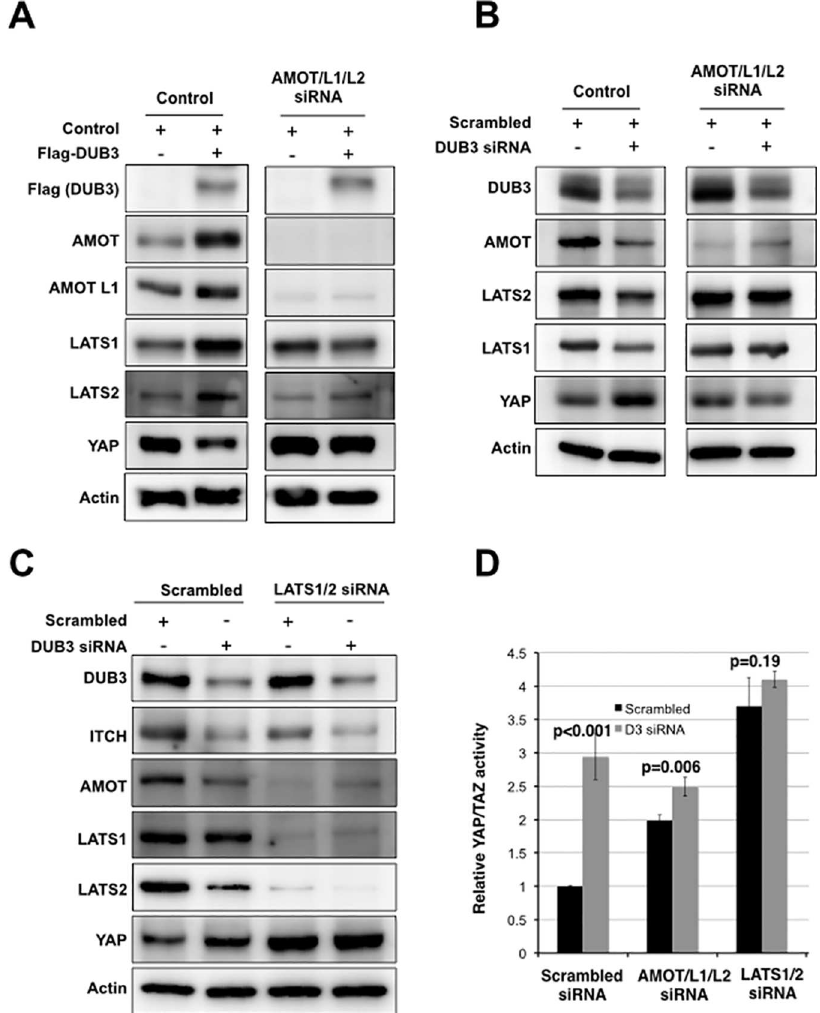
Fig 3. LATS and AMOT proteins are required for DUB3-mediated regulation of Hippo signaling. (A) Immunoblots showingthe effect of DUB3 expressionon LATS kinases, AMOT and YAP. HEK293T cells were transfected with a vector expressingFlag-DUB3or a control vector together with a mixture of siRNAs targeting AMOT, AMOTL1 and AMOTL2 or a scrambledsiRNA control. Blots were probedwith antibodies againstFlag, AMOT, AMOTL1, LATS1, LATS2 and YAP. Anti-Actin was used to control for loading.Samples were run on the same SDS-acrylamide gels with intervening lanes removed. (B) Immunoblots showingthe effect of DUB3 depletion on LATS kinases, AMOT and YAP. HEK293T cells were transfected with a vector expressingFlag-DUB3 or a control vector togetherwith a mixture of siRNAs targeting AMOT, AMOTL1 and AMOTL2 or a scrambledsiRNA control. Blots were probedwith antibodiesagainst DUB3, AMOT, LATS1, LATS2 and YAP. Anti-Actin was used to control for loading.Sampleswere run on the same gels with intervening lanes removed. (C) Immunoblots showingthe effect of DUB3 depletion on ITCH, LATS kinases and AMOT. HEK293T cells were transfected with a control or DUB3 siRNA in the presenceof LATS1 and LATS2 siRNAs or a scrambledsiRNA control. Blots were probedwith antibodiesagainstDUB3, ITCH, AMOT, LATS1, LATS2 and YAP. Anti-Actin was used to control for loading.(D) Luciferase reporter assays showing the effects of DUB3 siRNAs on YAP/TAZ activity. HEK293T cells were transfected to express the luciferase reporters togetherwith a control or DUB3 siRNA in the presenceof a mixture of siRNAs targeting AMOT, AMOTL1 and AMOTL2, a mixture of siRNAs targeting LATS1 and LATS2 or a scrambledsiRNA control. Data representthe averageof three independent transfectionexperiments ± SD. P values were determined using Student’s T-test